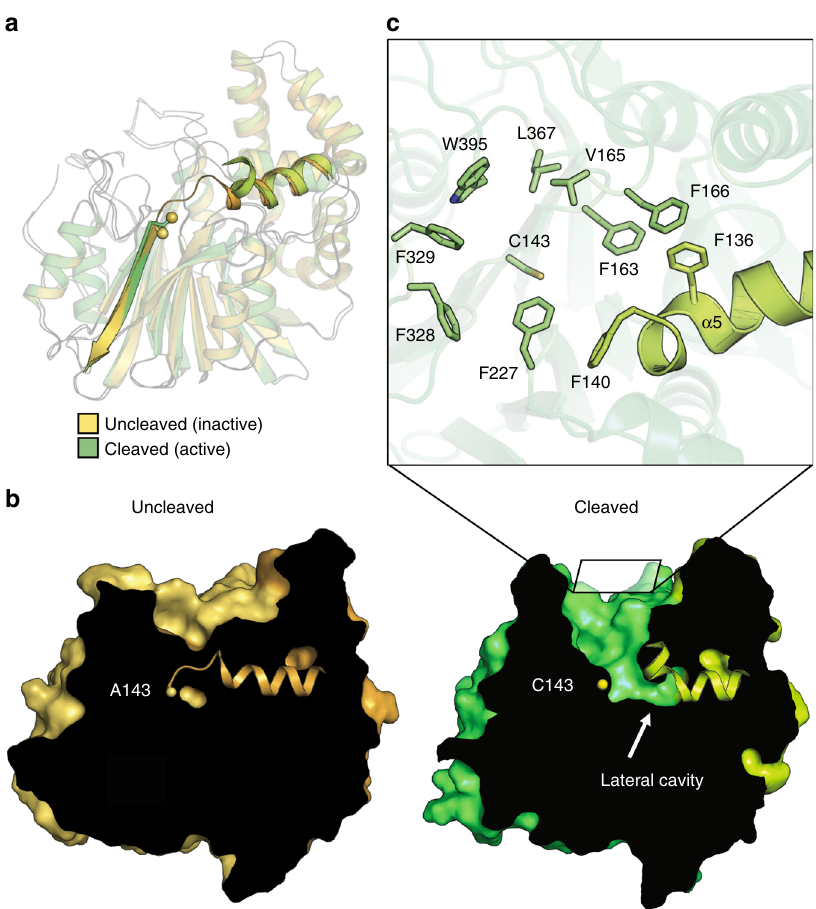
Fig. 3 Activation of aCDase. a Comparison of the active (human) and inactive (nmr) forms of aCDase. The inactive nmr-aCDase is in yellow ( β -subunit) and orange ( α -subunit). The active enzyme is in green ( β -subunit) and light green ( α -subunit). The active site Cys 143 is represented by yellow spheres in both structures. Helix- α 5 and strand- β 3 are emphasized to show the difference before and after cleavage. b Cutaways of the inactive (left, yellow) and active forms (right, green) of aCDase. Helix- α 5 is displayed as a ribbon. Ala 143/Cys 143 are shown as yellow spheres. The square above the cleaved enzyme indicates the direction of view in c . c The substrate binding channel exposed after autocleavage, viewed looking down into the channel. Hydrophobic residues in the channel that likely accommodate the ceramide lipid tails are shown as sticks ( β -subunit, green sticks; α -subunit, light green